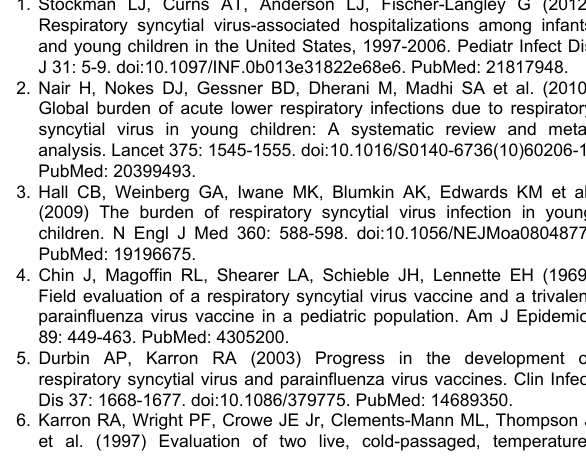
Table S4. Wild-type RSV/MEDI-559 ΔSH assay RT-PCR condition.